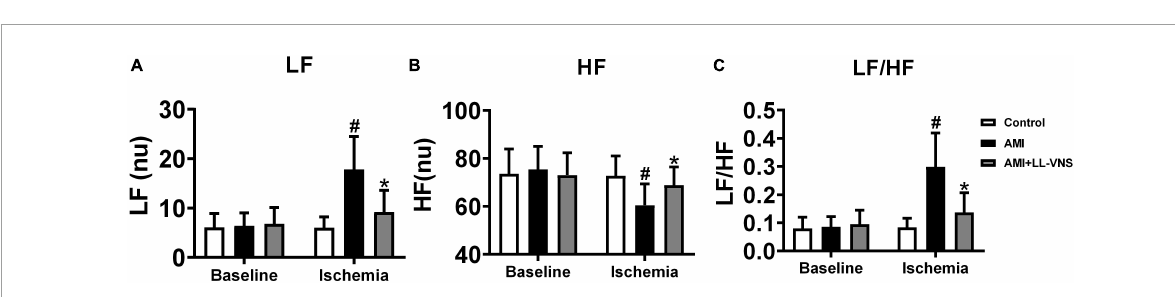
Figure 6C shows the effects of LL-VNS on ventricular SK2 mRNA expression. AMI increased SK2 expression in comparison with the Control group, while LL-VNS